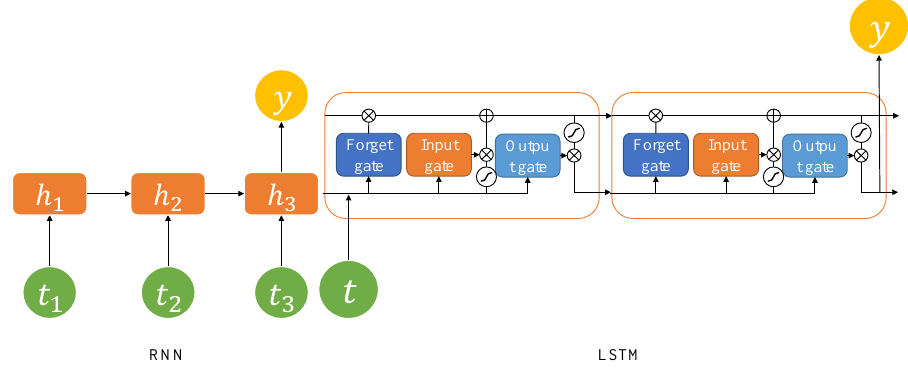
Figure 8. Visualization of the LSTM architecture [10].